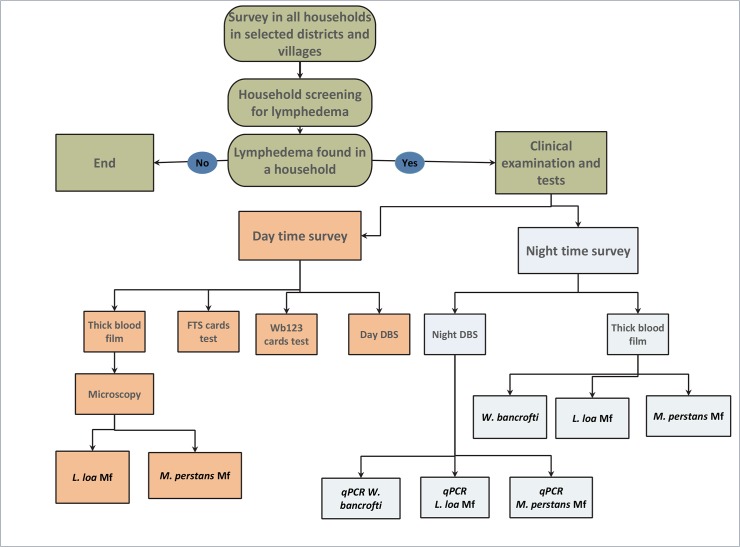
Flow-charts of the different tests used for the mapping of podoconiosis.